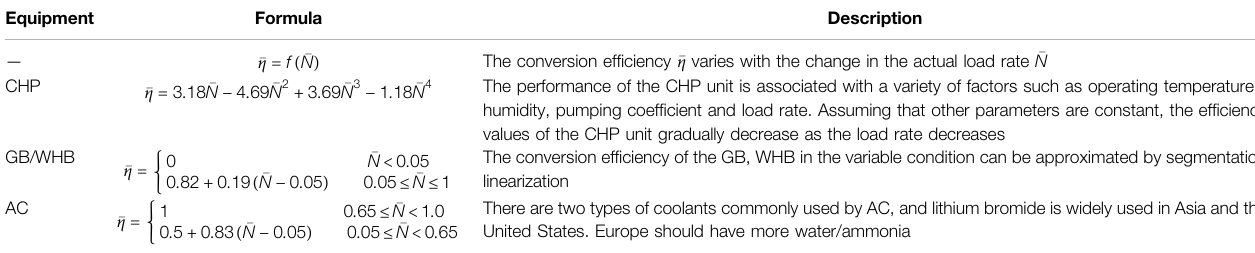
TABLE 2 | The equipment with obvious variable operating conditions in IES.